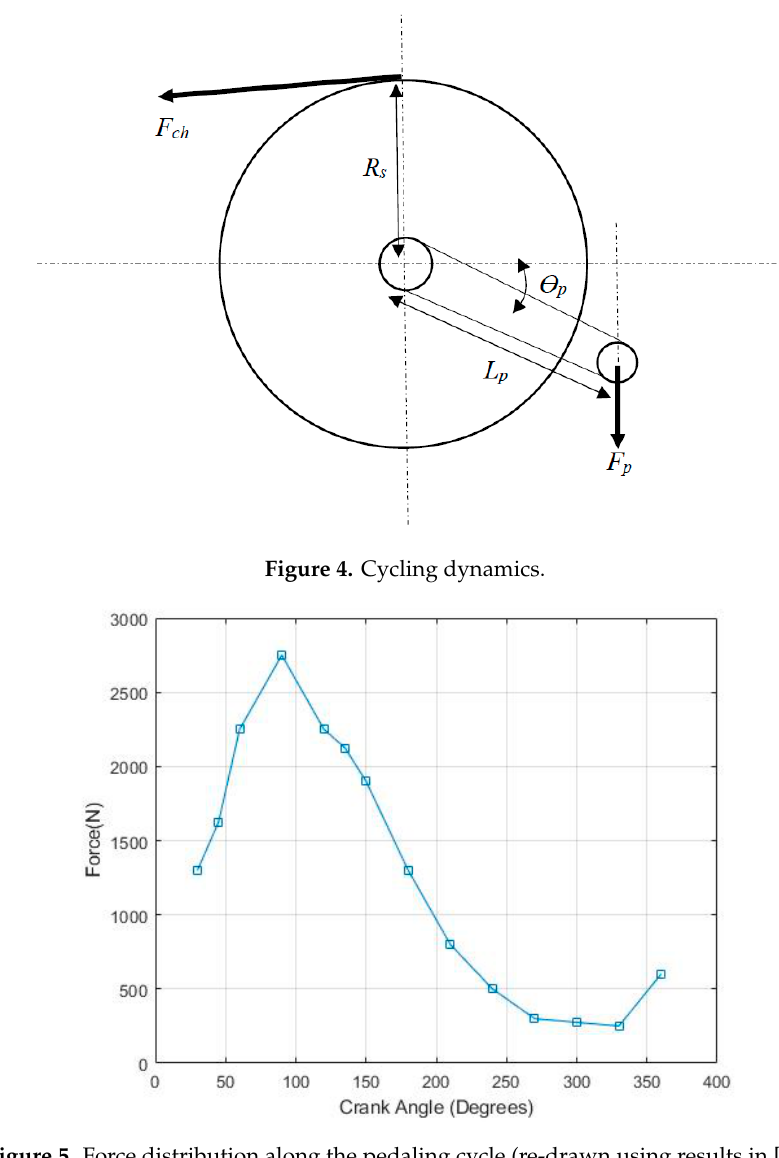
Figure 5. Force distribution along the pedaling cycle (re-drawn using results in [23]).